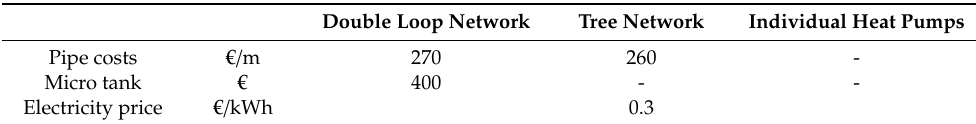
Table 2. Other capital and operating costs.